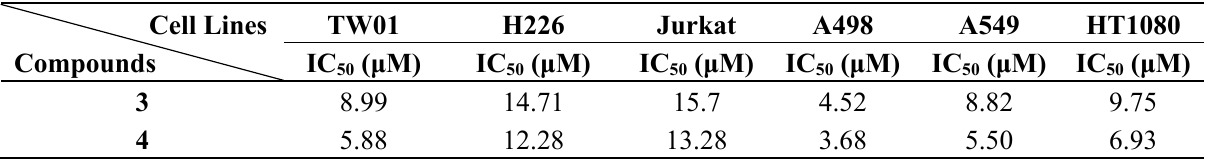
Table 2. Cytotoxicity of compounds 3 and 4